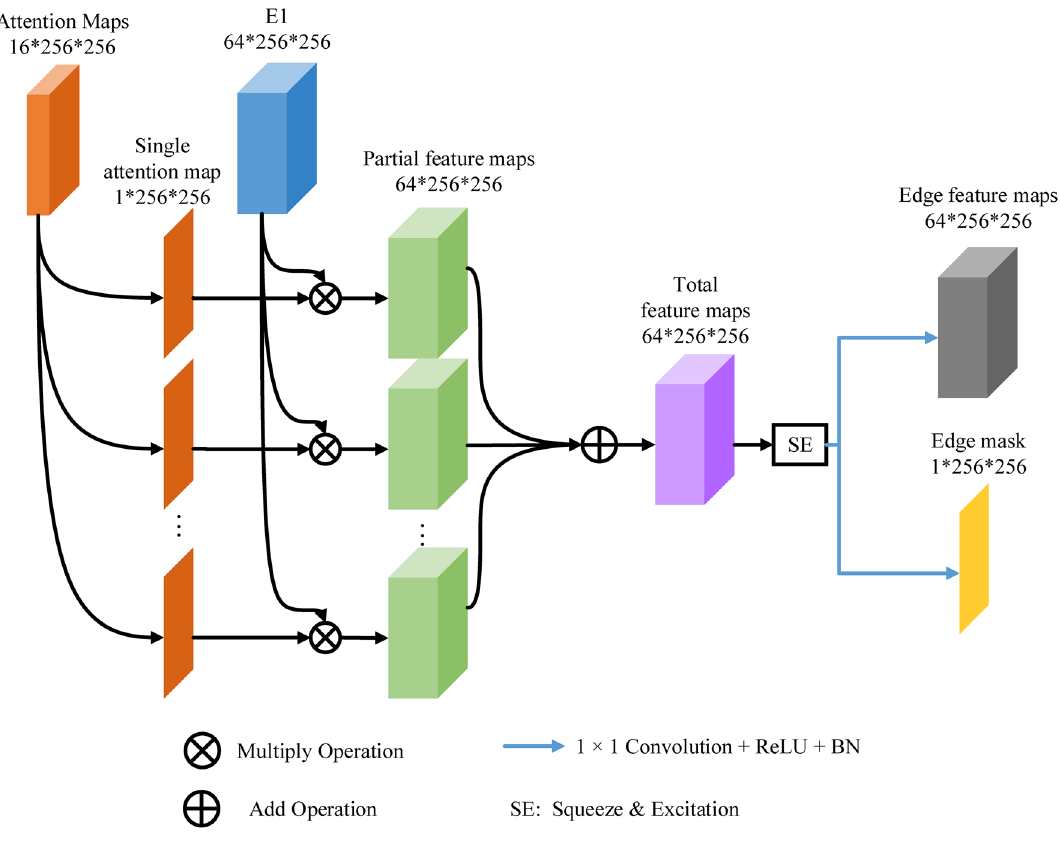
Figure 5. Multilayer attention